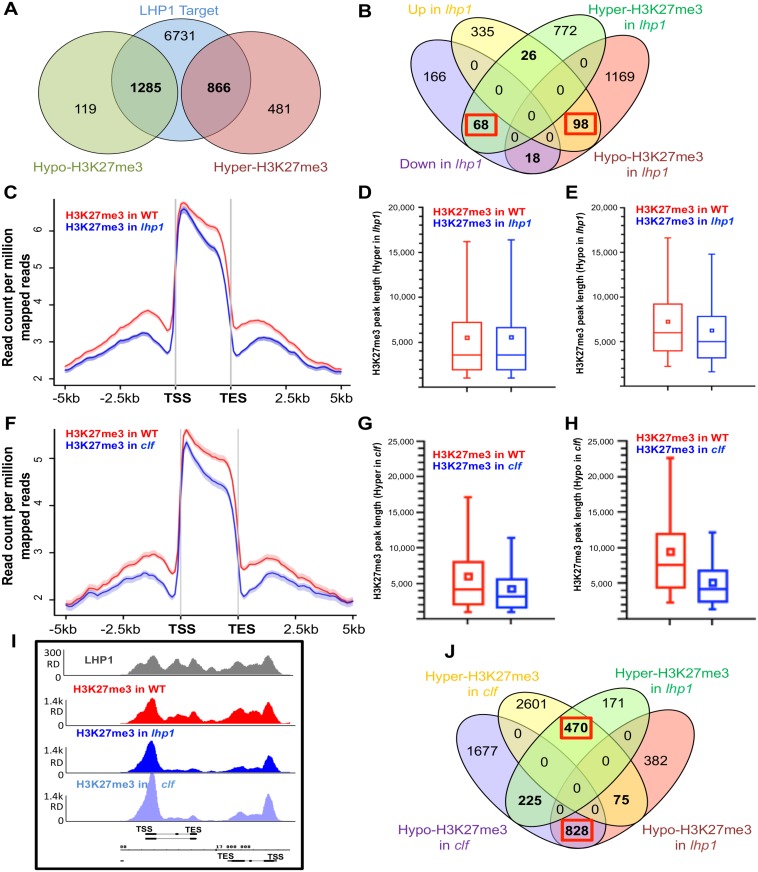
H3K27me3 spreading is affected in the lhp1 and clf mutants.(A) Venn diagram showing differential marking of H3K27me3 deposition and LHP1 binding. Hyper (Higher enrichment) and Hypo-H3K27me3 (lower enrichment) refers to differential marking of H3K27me3 in the lhp1 mutant compared to WT. (B) Venn diagram showing that Hyper-methylated (H3K27me3) genes are predominantly down-regulated in lhp1 and Hypo-H3K27me3 genes are up-regulated in lhp1, as highlighted by the red boxes. (C) H3K27me3 distribution pattern (tag density) over the CDS and flanking regions for WT and lhp1. Mean-normalized ChIP-Seq densities of equal bins along the gene and 5 kb region flanking the TSS or the TES were plotted. (D) Boxplot showing differential peak lengths of H3K27me3 in WT and lhp1 over Hyper-H3K27me3 region (Higher enrichment of H3K27me3 in lhp1, compared to WT). (E) Boxplot showing differential peak lengths of H3K27me3 in WT and lhp1 over Hypo-H3K27me3 region (Lower enrichment of H3K27me3 in lhp1, compared to WT). (F) H3K27me3 distribution pattern (tag density) over the CDS and flanking regions for WT and clf. Normalizaton of coverage densities of equal bins using spline algorithm was performed over the genes and flanking 5 kb region. (G) Boxplot showing differential peak lengths of H3K27me3 in clf and WT over Hyper-H3K27me3 region (Higher enrichment of H3K27me3 in clf, compared to WT). (H) Boxplot showing differential peak lengths of H3K27me3 in clf and WT over Hypo-H3K27me3 region (Lower enrichment of H3K27me3 in clf, compared to WT). (I) LHP1 binding andH3K27me3 deposition in WT, lhp1 and clf across two genes. Decreased level of H3K27me3 towards the 3’-end of both genes is observed in lhp1 and clf compared to WT. (J) Venn diagram showing differential H3K27me3 deposition in lhp1 and clf. A high overlapping of Hypo and Hyper-methylated genes can be observed between lhp1 and clf, as indicated in the red boxes.